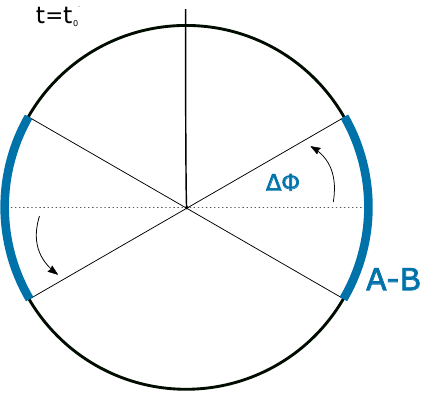
Figure 9 . Diagram of the spatial region A (cid:0) B for a (cid:12)xed time in one spatial